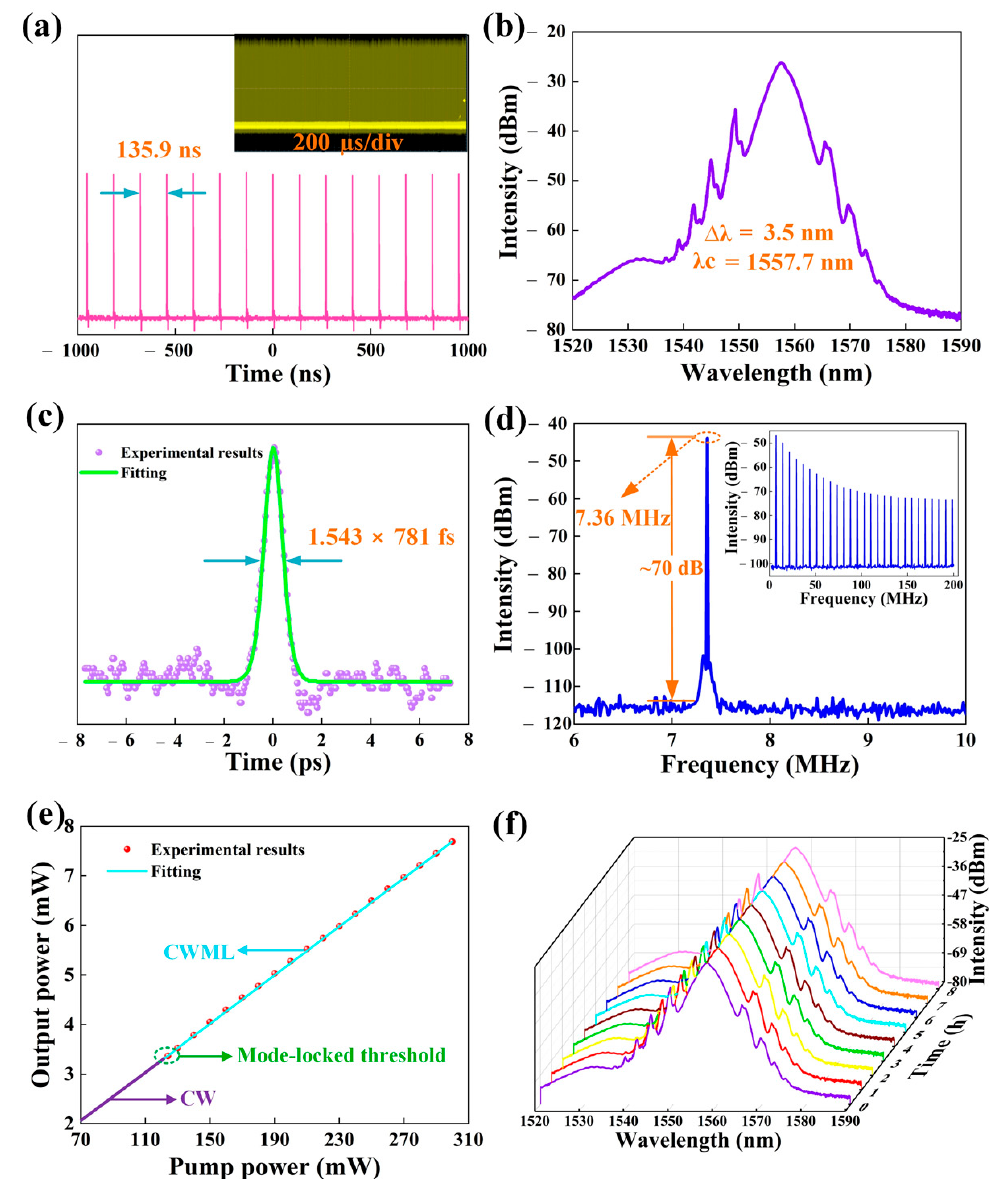
Figure 9. Typical ML EDF pulse characteristics. ( a ) Pulse train. ( b ) Optical spectrum. ( c ) Measure- ment of the laser pulse width. ( d ) RF spectrum (inset: wideband RF spectrum) of the ML pulses. ( e ) Variation in the output power with the pump power. ( f ) Optical spectra measurements at 1 h inter- vals over 8 h of operation.